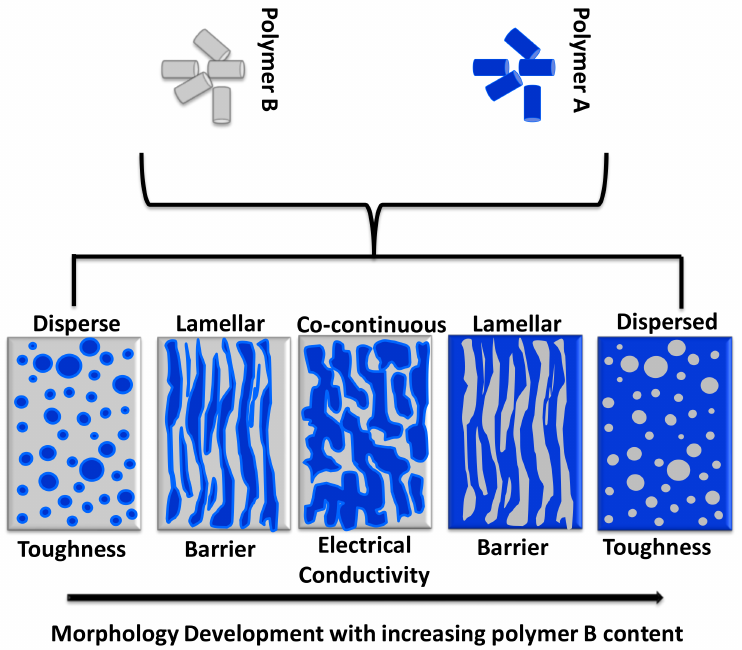
Figure 1. Polymer blend morphologies and their characteristic properties. The image was adapted from reference